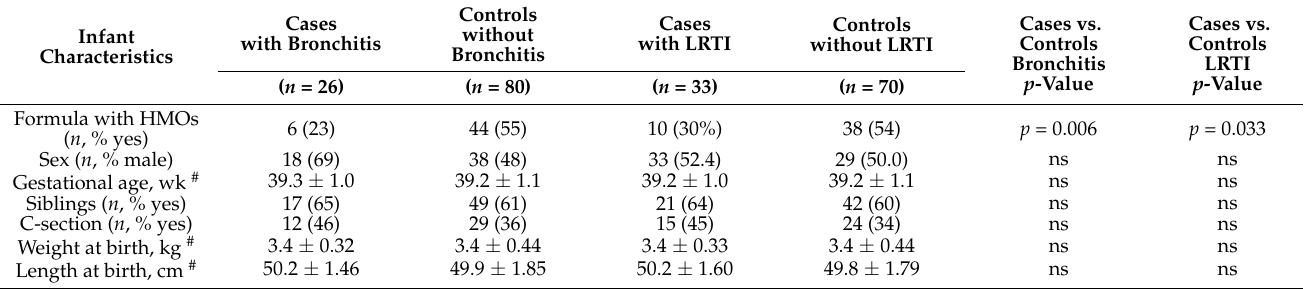
Table 1. Subject characteristics by case for bronchitis and LRTI and respective controls